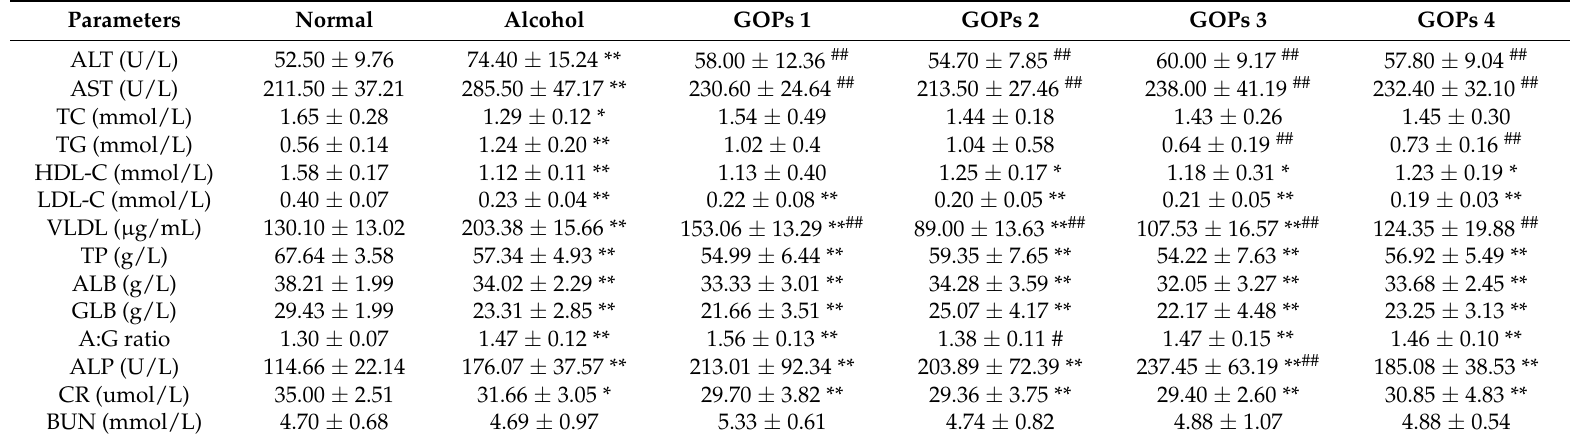
Table 4. Effects of GOPs on aminotransferase, lipid, protein, urea nitrogen, and creatinine in the serum of